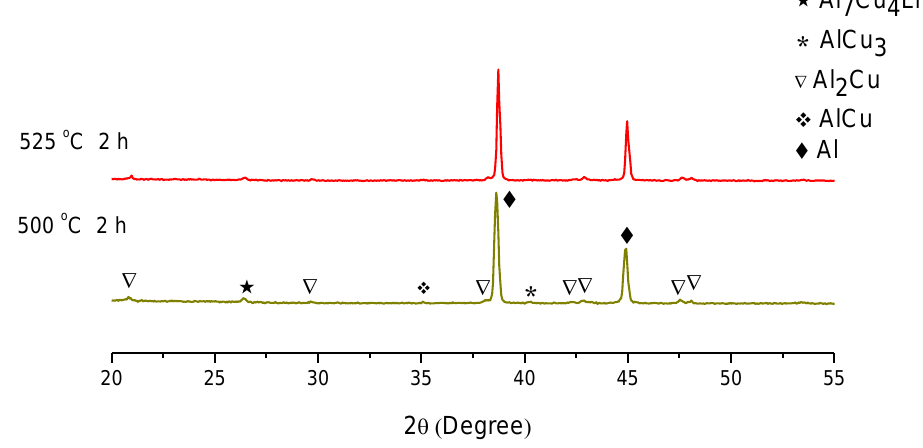
Figure 13. X-ray diffractograms of HT compacts at different temperatures and times.